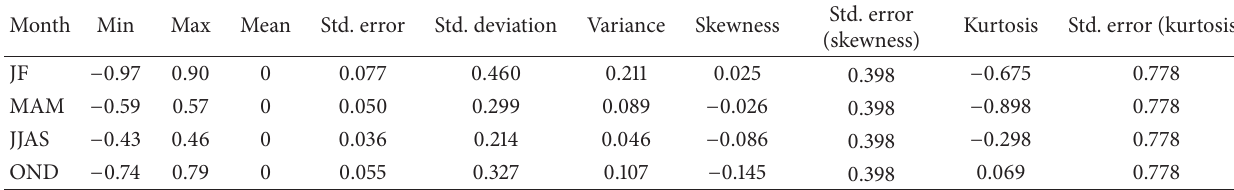
Table 2: General statistics of temperature at 1000 hPa.